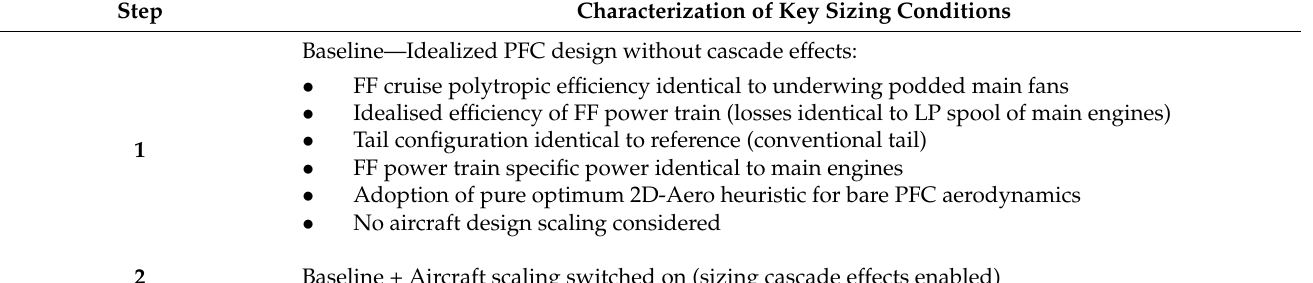
Table 17. Individual steps for incremental analysis of effects on PFC fuel